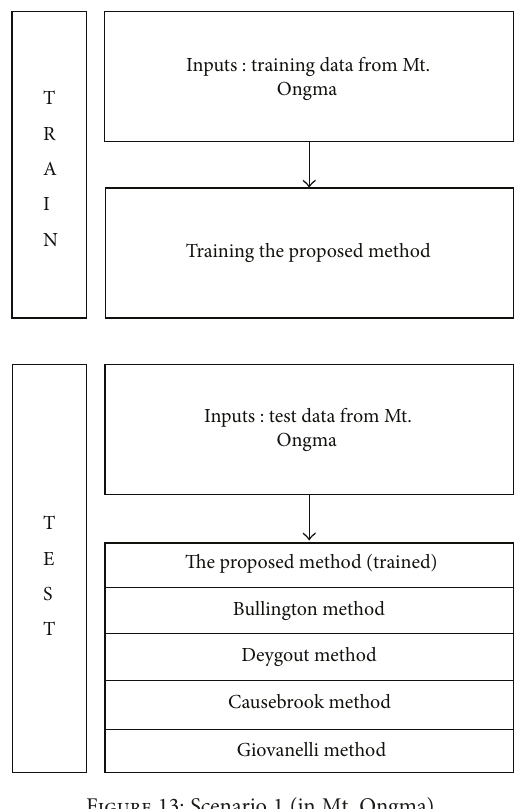
Figure 13: Scenario 1 (in Mt. Ongma).